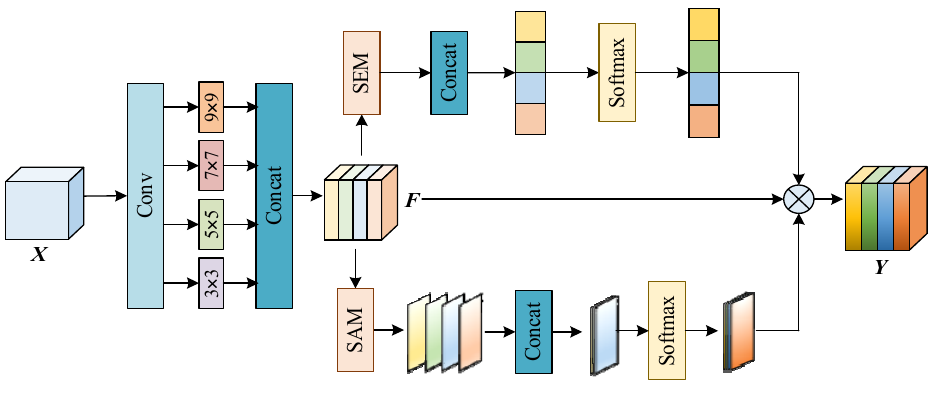
Figure 6. Multi-scale hybrid attention module.